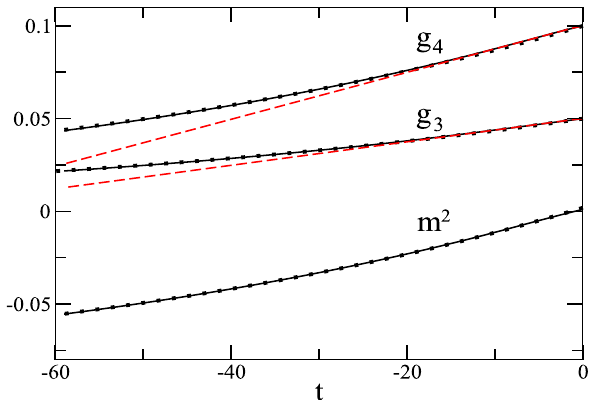
Fig. 1 UV flow of thecouplings g 3 , g 4 , withboundaries fixed at t = 0, for two different values of n , namely n = 22, black solid lines, and n = 6, red (online) dashed lines. At t = 0, for all g n with n even and 4 ≤ n ≤ n , the boundary value 0 . 1 is used, while 0 . 05 is used for odd n . The flow of m 2 = g 2 is also displayed for n = 22 with boundary value 10 − 3 for m 2 and the same boundaries as before for the other couplings. Dotted black lines correspond to the exponential approximation, as in Eq. (26), to the various